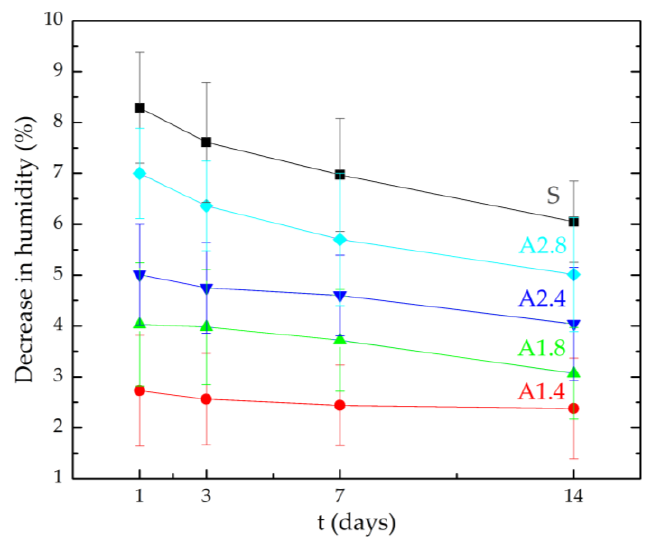
Figure 2. The decrease in humidity after 7, 14 and 28 days. Table 6. Durability and physical properties of lightweight mortars.